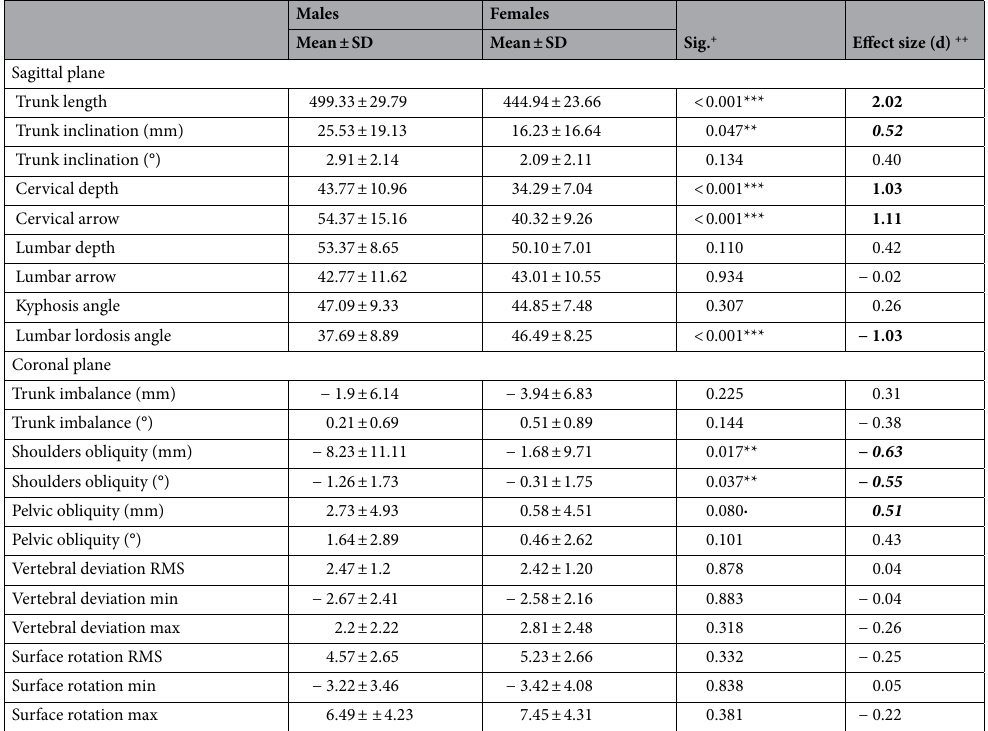
Table 2. Rasterstereographic measures of the sagittal and coronal plane. + according to t-test for normal data and Mann–Whitney U for non-normal data · p < 0.1, * p < 0.05, ** p < 0.01, *** p < 0.001. ++ Cohen’s value, bold numbers indicate a large effect size between groups (d > 0.80). Bold and italic numbers indicate a medium effect size between groups (d > 0.50).